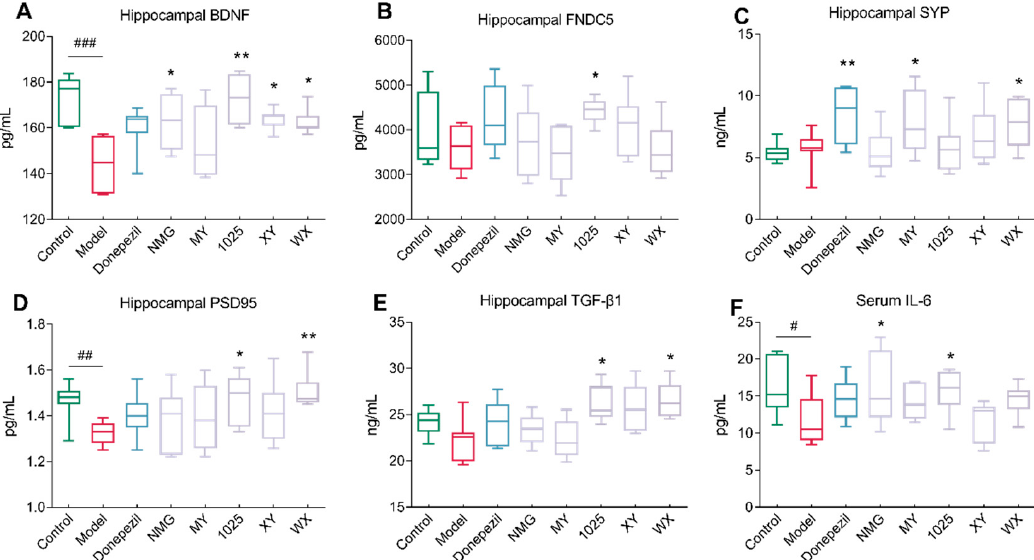
Figure 4. Effect of Bifidobacterium breve treatment on brain, neuroinflammation, and synaptic function. ( A ) Hippocampal BDNF levels ( n = 6–8). ( B ) Hippocampal FNDC5 levels ( n = 6–8). ( C ) Hippocampal SYP levels ( n = 6–8). ( D ) Hippocampal PSD95 levels ( n = 6–8). ( E ) Hippocampal TGF- β 1 levels ( n = 6–8). ( F ) Serum IL-6 levels ( n = 6–8). In the box plot, the bottom and top are, respectively, the 25th and 75th percentiles, and a line within the box marks the median. Whiskers above and below the box indicate the 1.5 interquartile range of the lower and upper quartiles, respectively. Control vs. Model: # p < 0.05, ## p < 0.01, ### p < 0.001 by unpaired student’s t -test; * p < 0.05, ** p < 0.01 by one-way ANOVA for all groups.